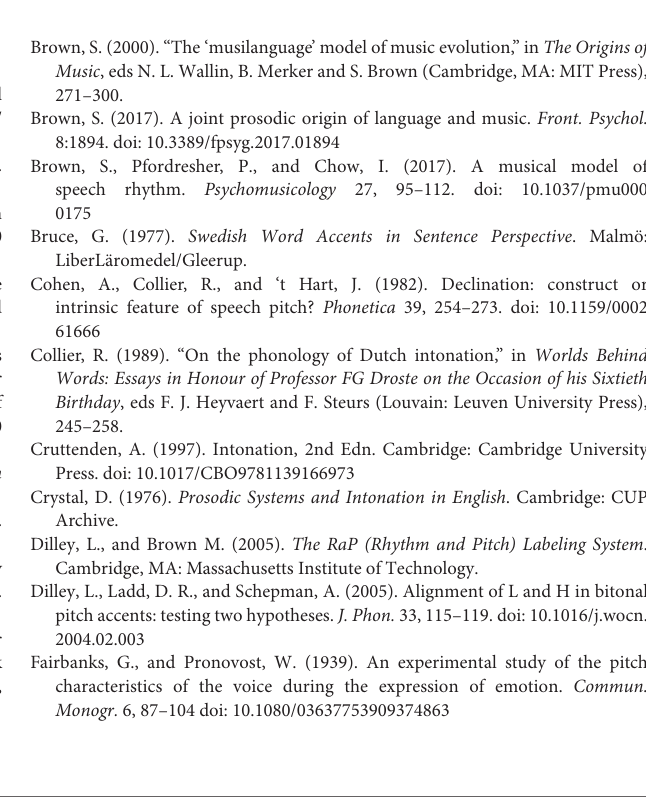
Figure 7C : “Whose telephone is that?”. Figure 11 uses rhythmic transcription to demonstrate three different manners of intoning this question, the first of which was used in Figure 7C (for simplicity, a single G pitch is used in all transcriptions). Each variant differs based on where the point of focus is, as shown by the word in block letters in each transcription. We chose the version in Figure 10A for our group analysis in Figure 7C , since the melodic pattern of the group average best fit that pattern, with its high pitch on “whose,” rather than on “telephone” or “is.” Hence, while the examination of group averages might tend to downplay inter-participant variability, the transcriptional approach is able to capture the family of possible variants for a given sentence and use them as candidates for the productions of individuals and